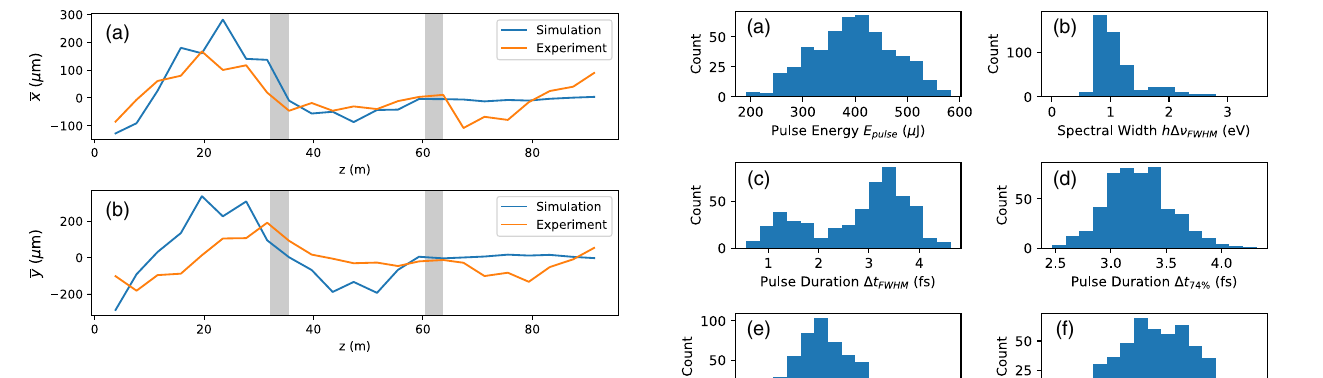
FIG. 11. Horizontal and vertical center-of-mass orbits of the bunch in the undulator line. Two gray blocks show the locations of two chicanes in the undulator beam line.